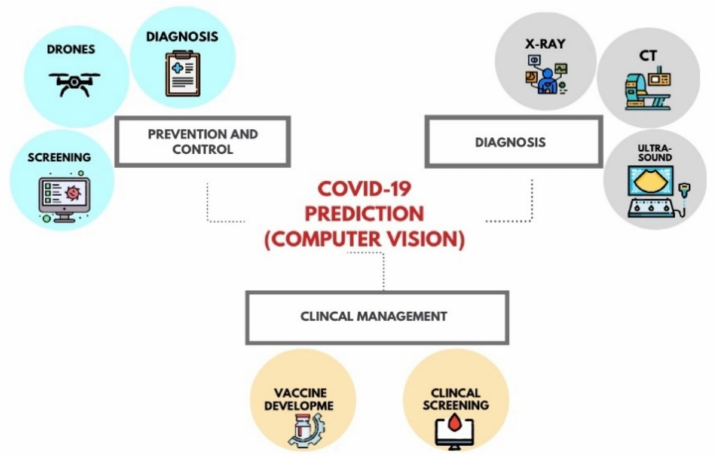
Figure 2. Classification of computer vision approaches to